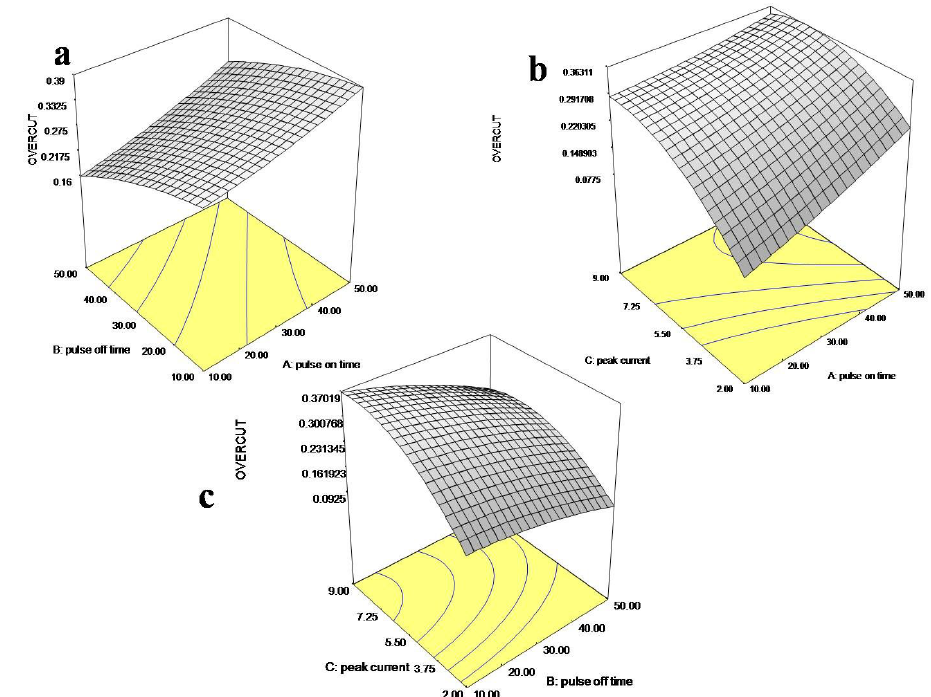
Figure 8: Interaction Plots for Overcut (a) Ton Vs Toff; (b) Ton Vs Ip; (c) Toff Vs Ip Table 7: Material migration in magnetic field assisted EDM Control Factors Material migration to machined samples (%) Sample No.